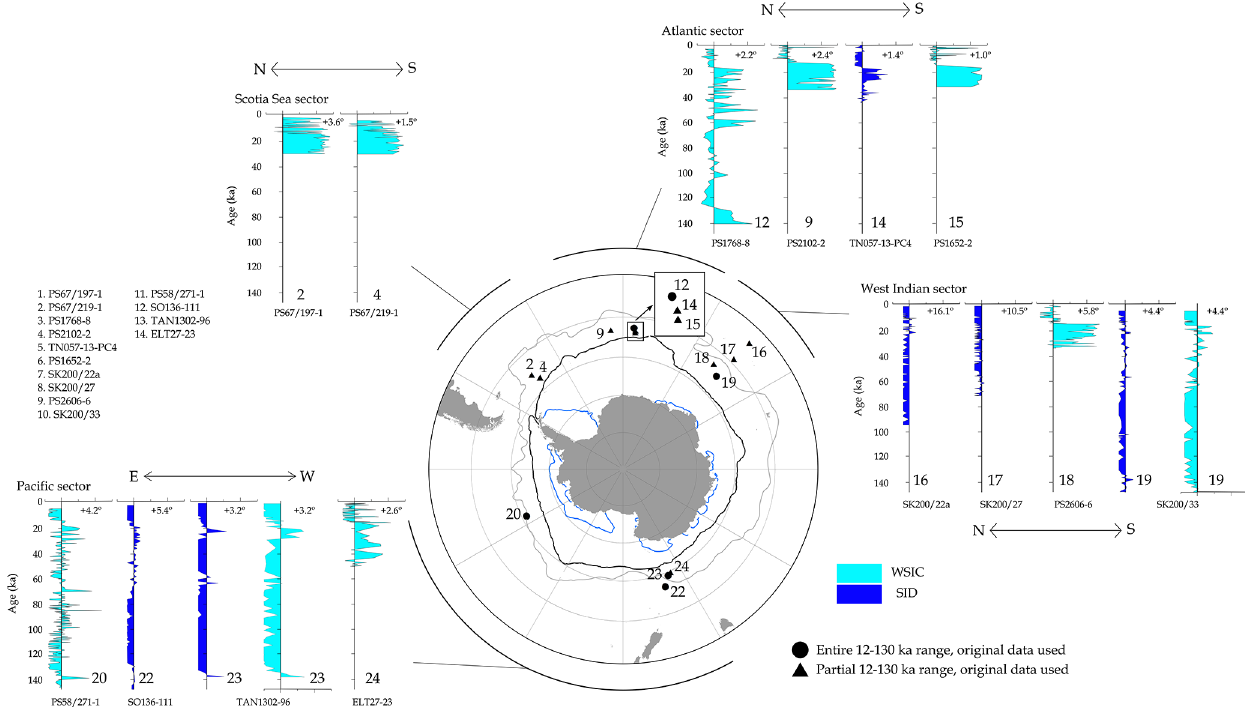
Figure 3. Standardised WSIC (winter sea-ice concentration) and SID (sea-ice duration) records from Southern Ocean marine sediment cores shown alongside a map of Antarctica with core locations, modern February (blue line) and September (black line) sea-ice extents (data from Fetterer et al., 2017) and the modern Antarctic Polar Front position (grey line; Trathan et al., 2000). Downcore records are arranged together in Southern Ocean regions, with distance from the modern winter sea-ice (WSI) edge given in degrees latitude (plus sign indicates locations north of the mean WSI edge, minus sign indicates locations south of the mean WSI edge). Unlike in Figs. 1 and 2, records from the East and Central Atlantic sectors have been combined into a single Atlantic sector